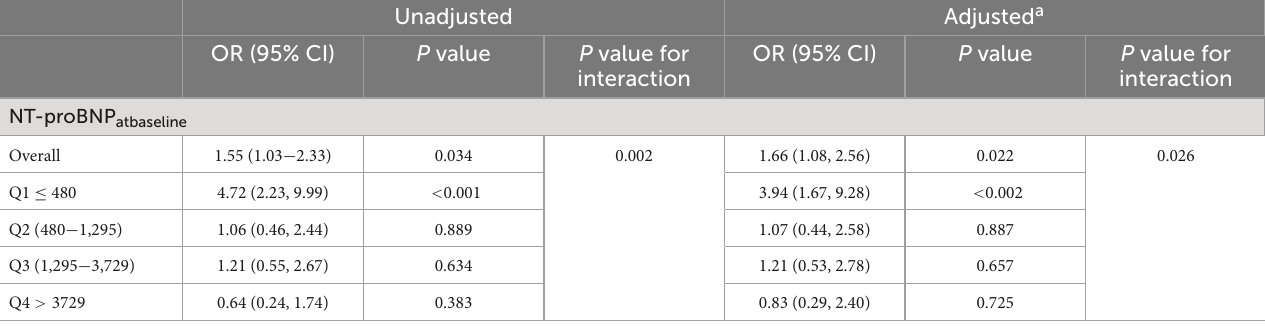
TABLE 4 Odds ratios for 90-day renal non-recovery associated with decreased change in NT-proBNP within quartiles of baseline NT-proBNP levels. Unadjusted Adjusted a OR (95% CI) P value P value for OR (95% CI) P value P value for interaction interaction NT-proBNP